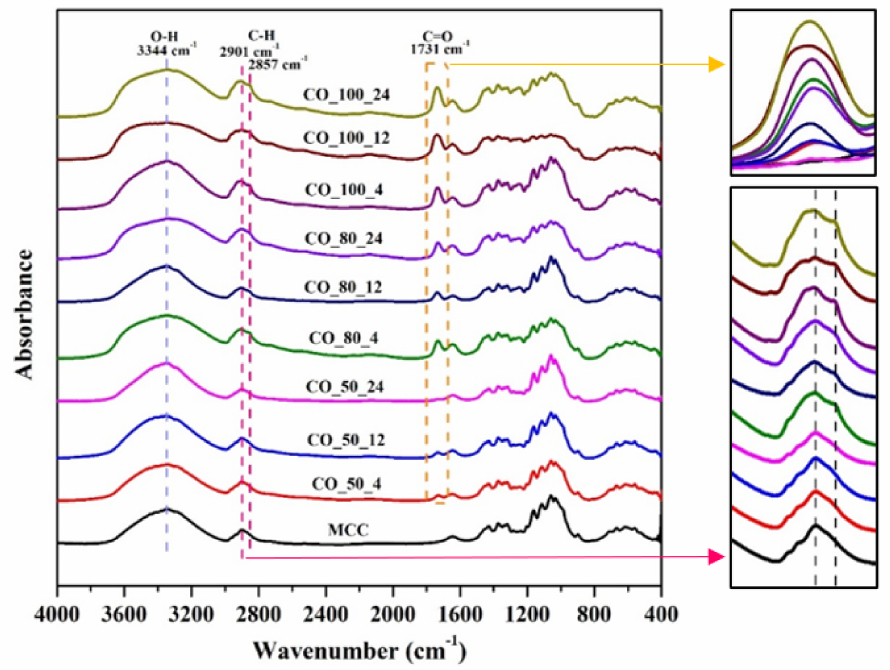
Figure 2. FTIR spectra of cellulose oleates synthesized at different reaction time (4, 12, and 24 h) and reaction temperature (50, 80, and 100 ◦